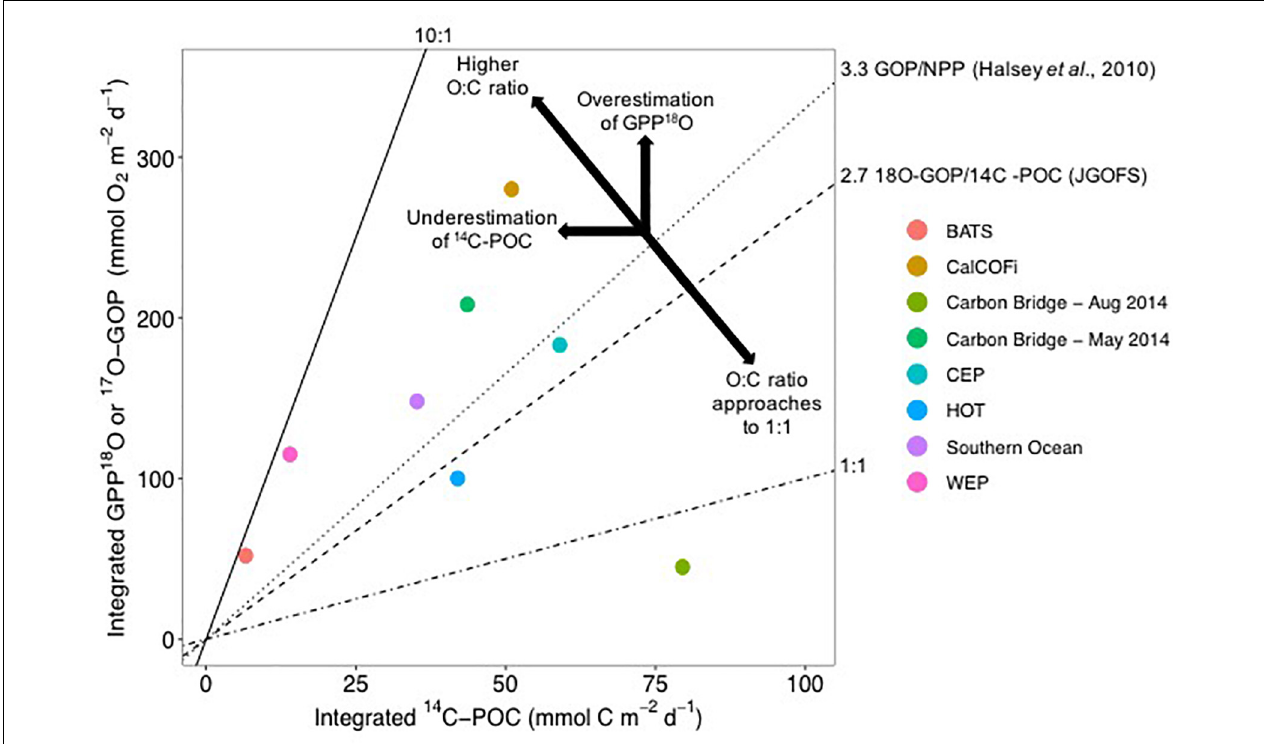
FIGURE 6 | Average O:C ratios from 14 C-POC and mixed-layer Gross oxygen production (GOP), equivalent to GPP- 18 O in this study (Carbon Bridge – May and August 2014), estimated from incubations of 18 O and DO. All rates are integrated, with units of mmol m − 2 d − 1 . BATS correspond to the Bermuda Atlantic Time Series, CalCOFI to the California Cooperative Fisheries Investigations, Carbon Bridge 2014 (this study), CEP to the Central Equatorial Pacific, HOT to the Hawaii Ocean Time Series, and WEP to the Western Equatorial Pacific. 14 C-POC corresponds to 14 C-PP in the literature. For the Arctic, a median of 4.75 for May, with 25 and 75% percentiles of 2.6 and 7.6, respectively, and for August, a median of 0.56 with 25 and 75% percentiles of 0.5 and 0.8, respectively. Factors overestimating GPP- 18 O include photo-enhanced mitochondrial respiration, chloro-respiration, photo-respiration, and Mehler reaction, which increase oxygen consumption not related to carbon uptake. 14 C-POC can be underestimated by grazing and DOC excretion as well as photo-respiration where 14 C is consumed within the incubation vessel (see text for more details). Graph redrawn from Juranek and Quay